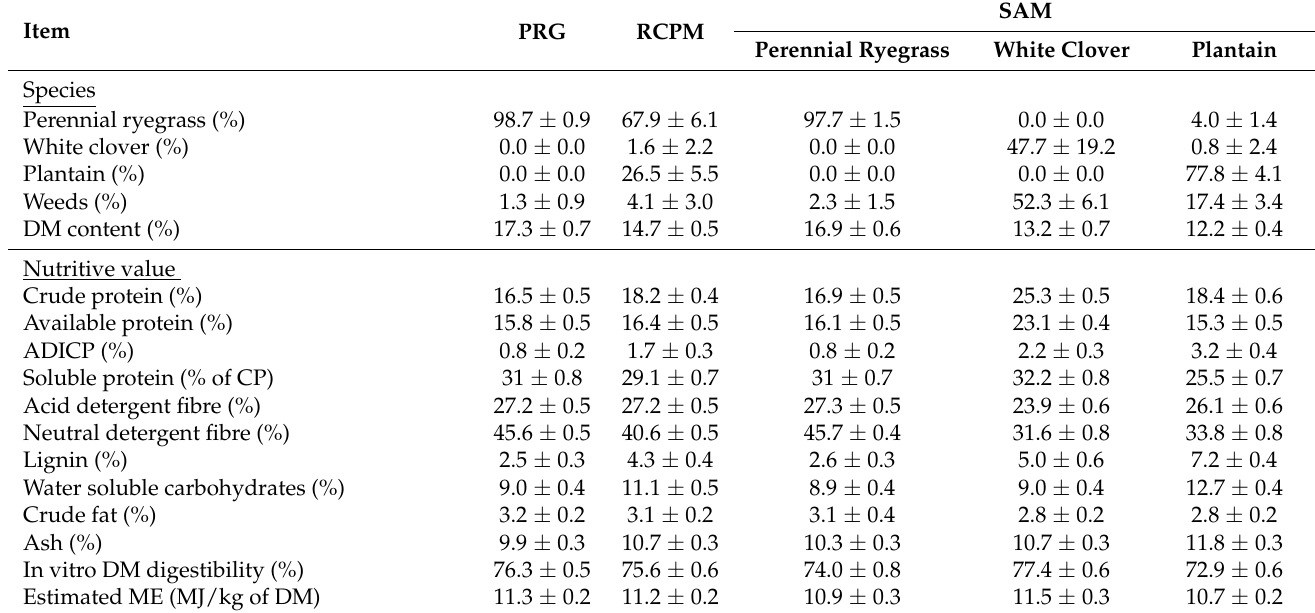
Table 2. Botanical composition (% species on a DM basis) and nutritive value of forage offered to cows grazing each forage type, including PRG, perennial ryegrass monoculture; RCPM, perennial ryegrass, white clover and plantain mixture; and SAM, spatially adjacent monocultures of perennial ryegrass, white clover and plantain. Values presented are means ± SE ( n = 10). Abbreviations include ADICP, acid detergent insoluble crude protein and ME, metabolisable